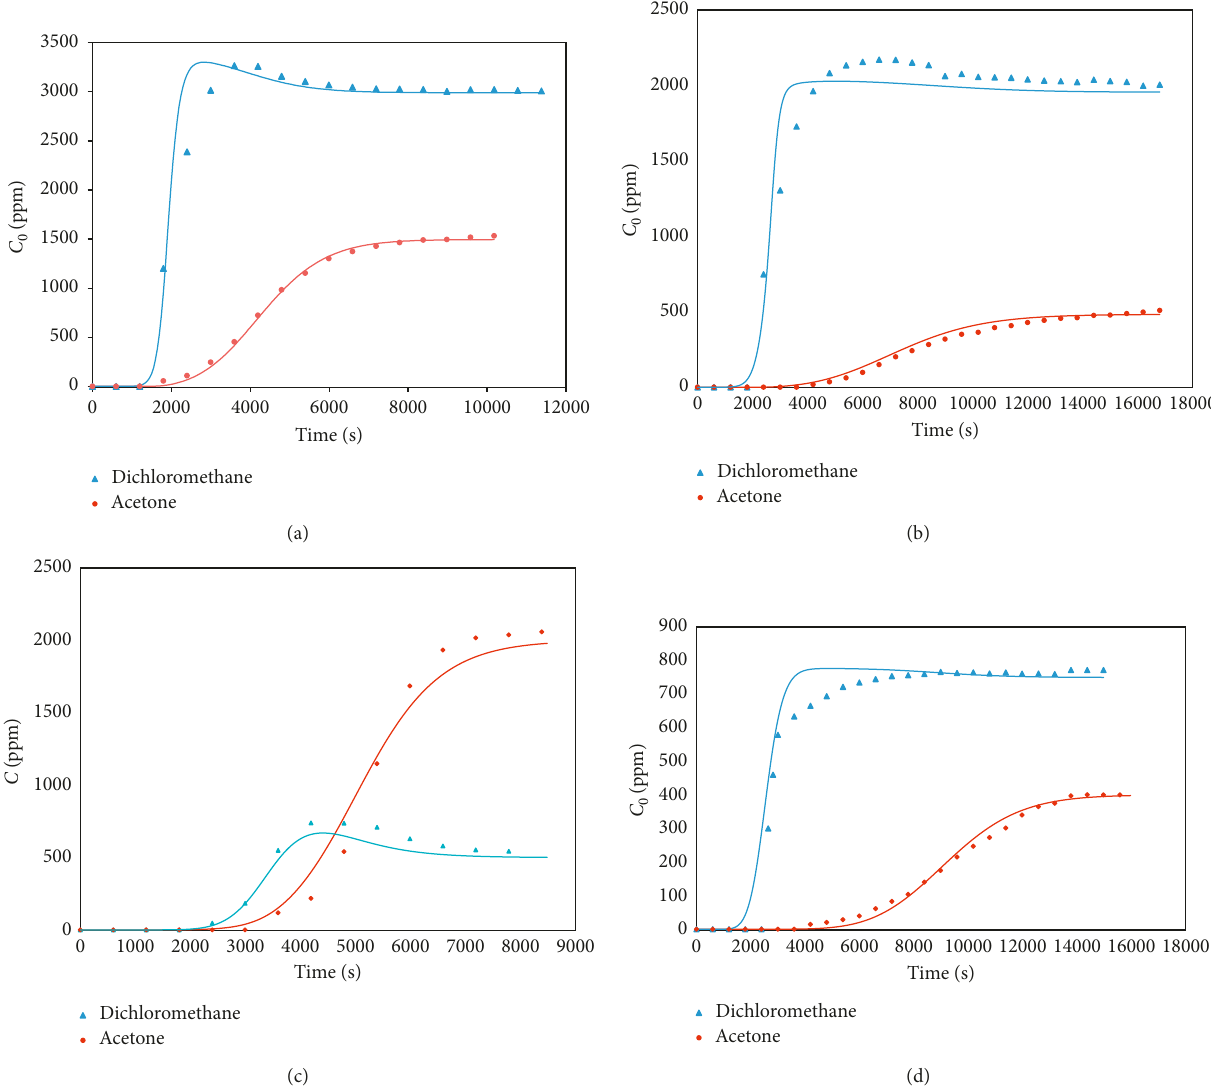
Figure 7: Breakthrough curves of mixtures of dichloromethane and acetone for different compositions: (a) 3000ppm/1500 ppm, (b) 2000ppm/500 ppm, (c) 500ppm/2000ppm, and (d) 750 ppm/400ppm on activated carbon, at 298K and atmospheric pressure. Symbols: experimental data. Lines: LDF